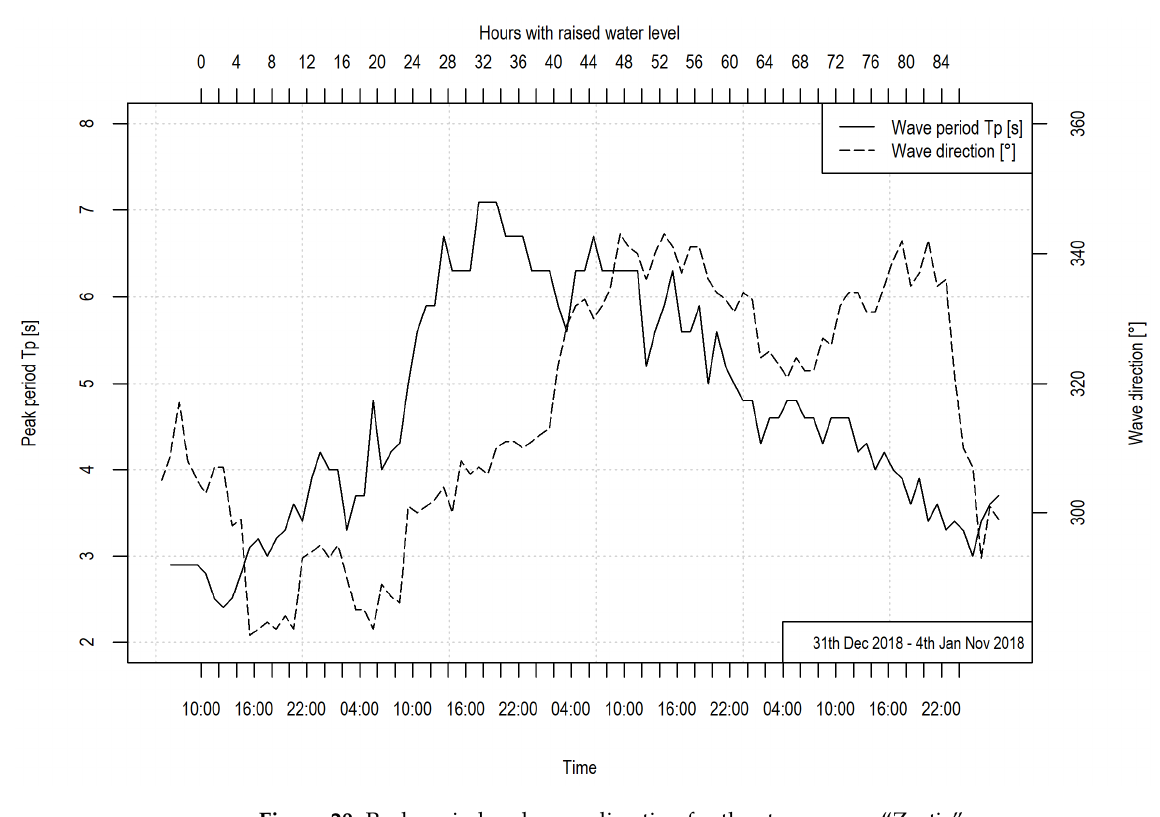
Figure 20. Peak period and wave direction for the storm surge “Zeetje”.